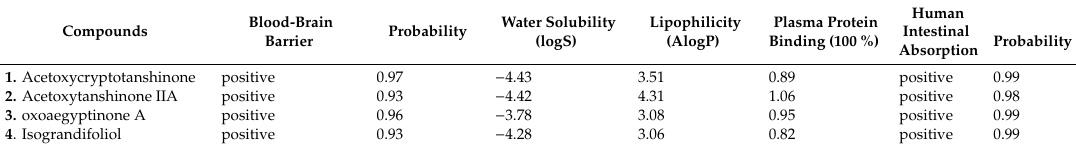
Table 4. Results obtained from computational prediction using the admetSAR